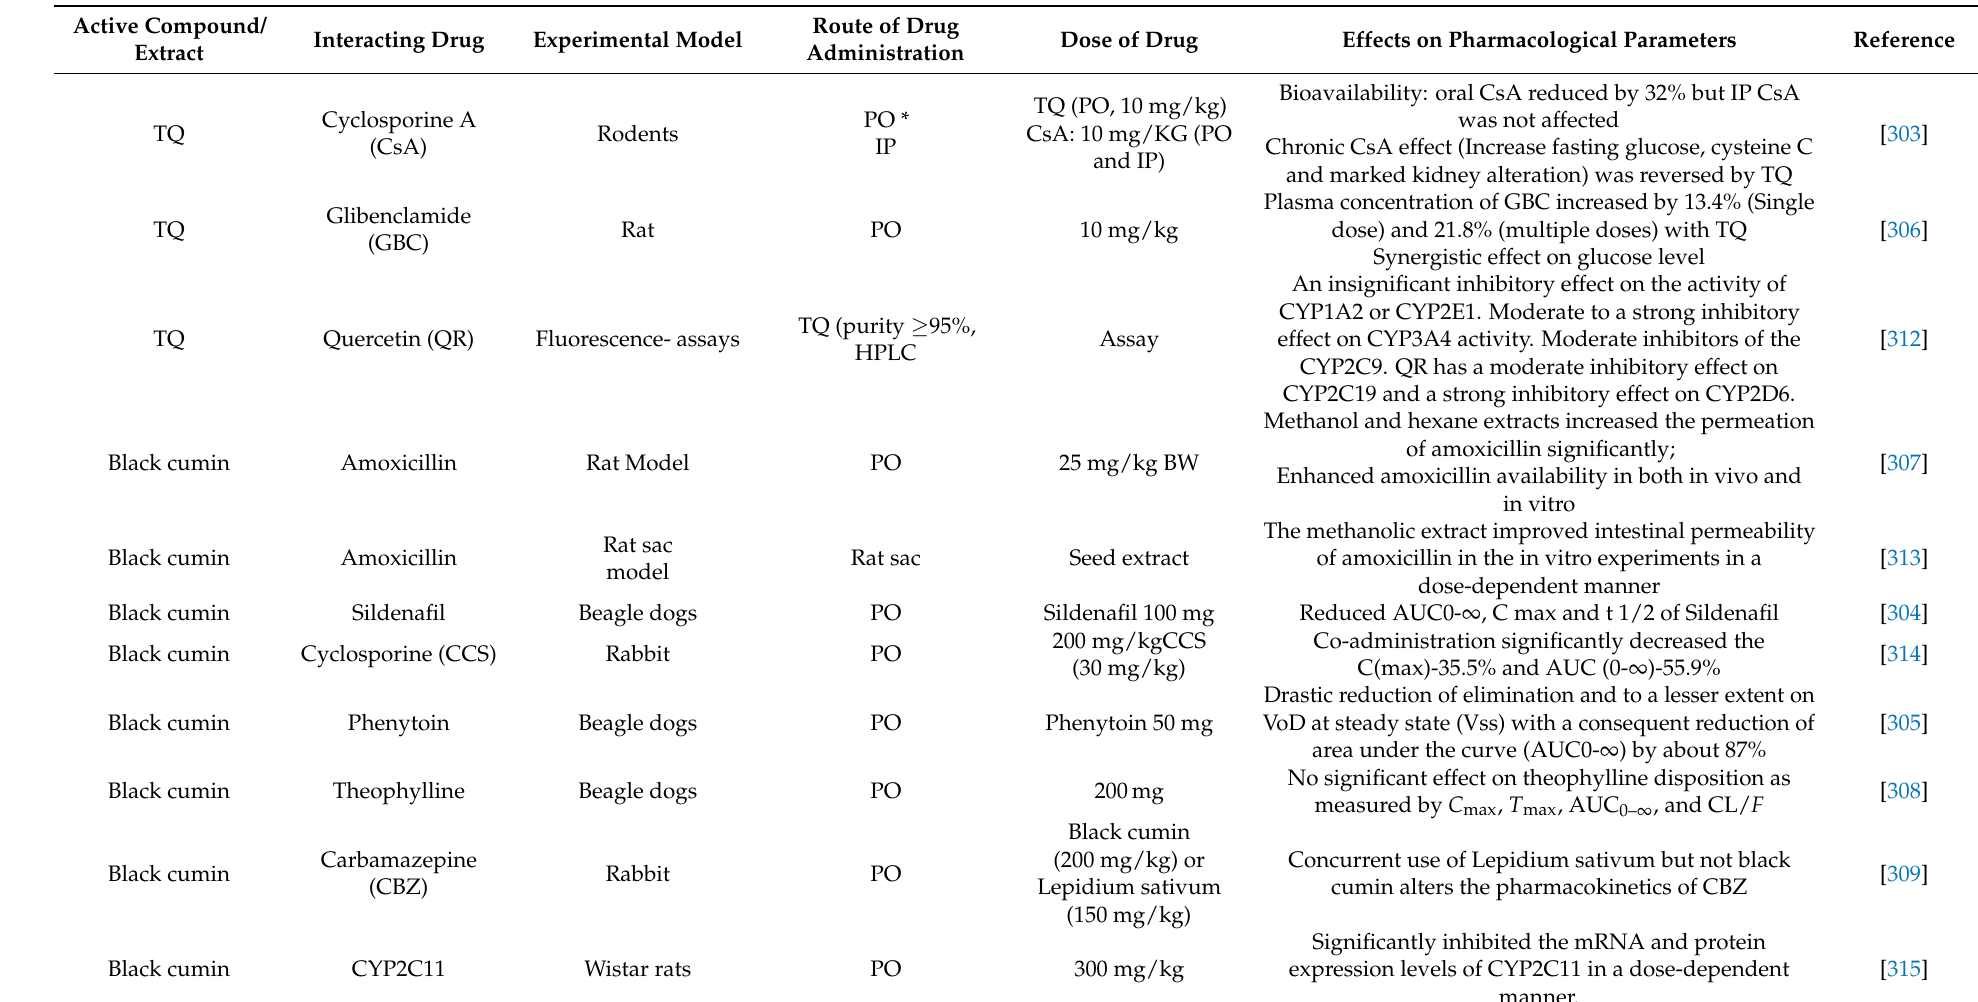
Table 12. Drug interaction with black cumin and corresponding pharmacological